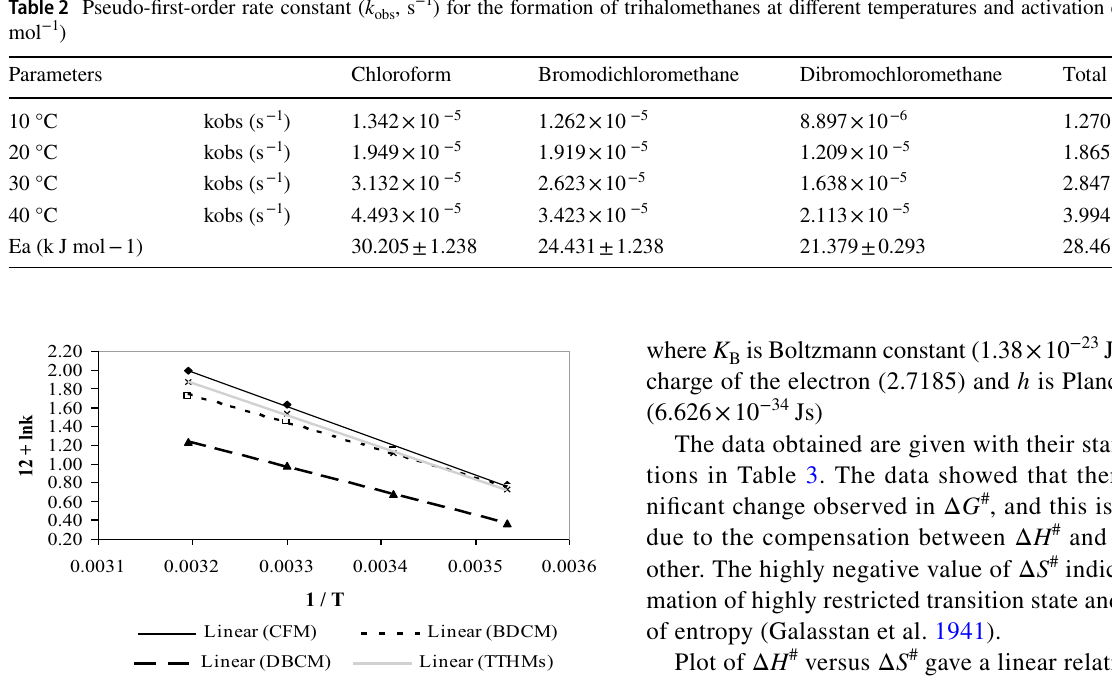
−1 ) for the formation of trihalomethanes at different temperatures and activation energy (Ea, k J obs , s